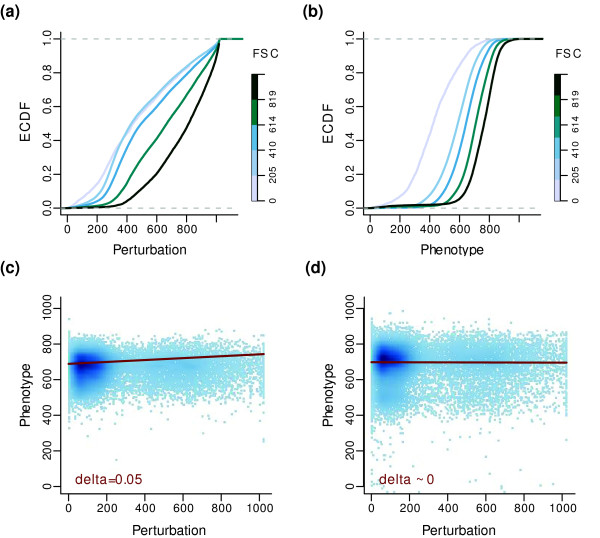
Correlation of fluorescence and cell size. Empiric cumulative distribution functions (ECDF) of fluorescence values for (a) perturbation and (b) phenotype showing their positive correlation with cell size. The fluorescence values were stratified into subsets corresponding to five quantiles (0-20%, 20-40%, 40-60%, 60-80%, and 80-100%) of cell size (forward light scatter), and the ECDF for each stratum was plotted in a different color. With increasing cell size, an increase in fluorescence values is also observed. (c) Regression line fitted to the data showing spurious correlation between the two parameters. In this case, the perturbation is known to cause no phenotype, and hence the correlation is considered to be artifactual. (d) After adjusting for cell size, the two parameters are uncorrelated.